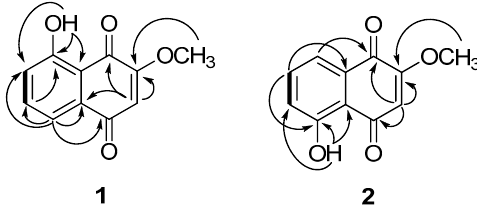
Figure 2. Key COSY ( ▬ )and HMBC ( → ) correlations of 1 and 2 .